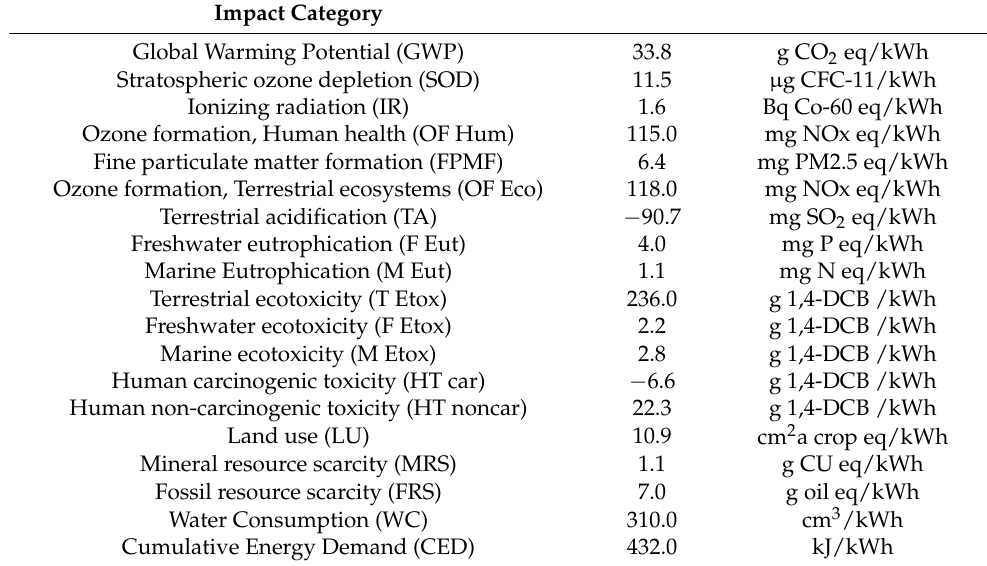
Table 5. Results of LCIA and CED calculation with